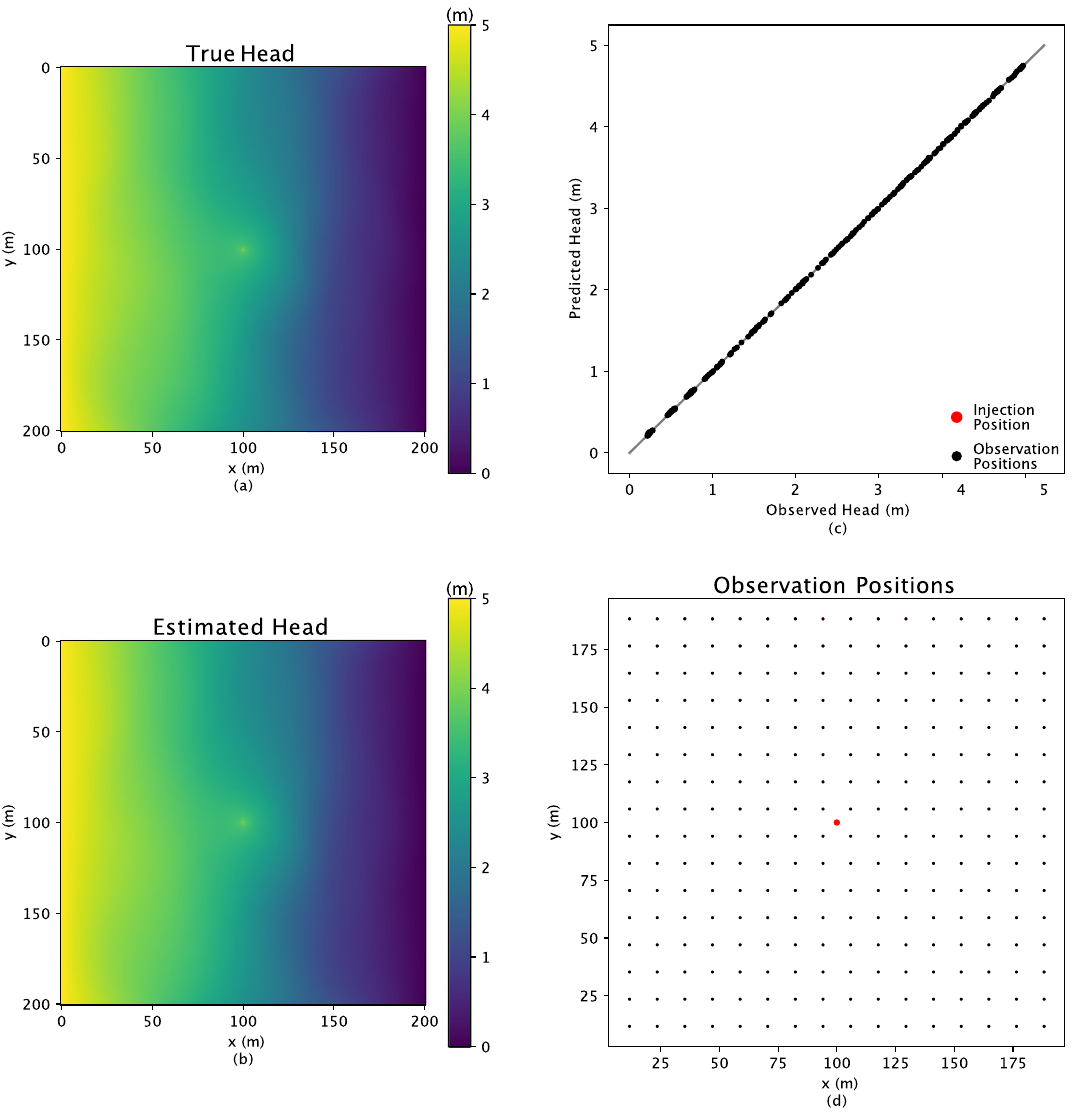
Figure 3. The head distribution of the reference conductivity field is shown in subfigure ( a ), and subfigure ( b ) shows the corresponding inverse estimated head distribution. The black dots in subfigure ( d ) represent the 16 × 16 regular grids for observation points, and the one red dot illustrates the injection position, with a rate of 1.0 m /s. Finally, the comparison of the observed head and predicted head for all the observational points are shown in subfigure ( c